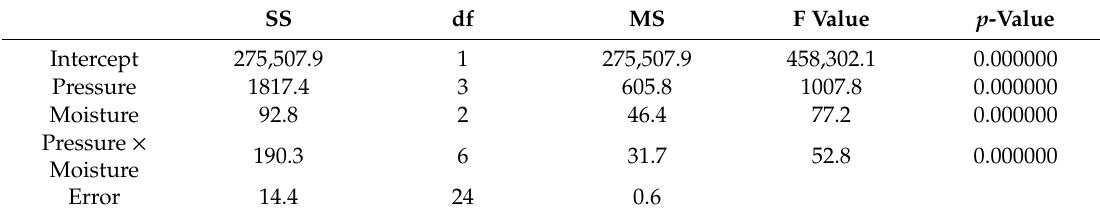
Table 5. Two-way ANOVA—DU.